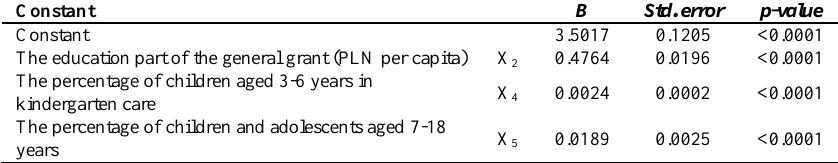
Table 4. The regression results for education expenditures in municipalities with moderate own revenue in 2016 (N=817)